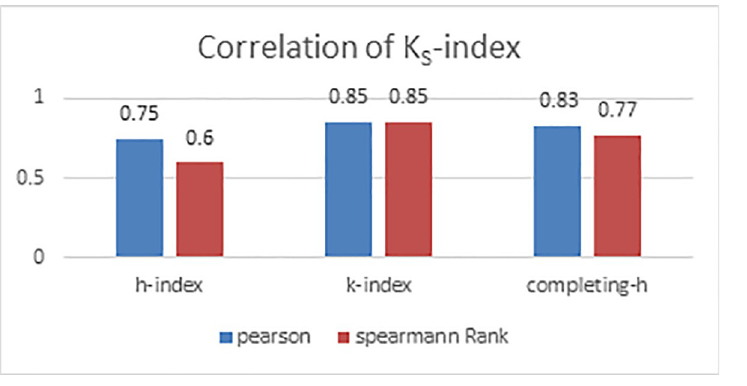
Fig 5. Correlation of K S